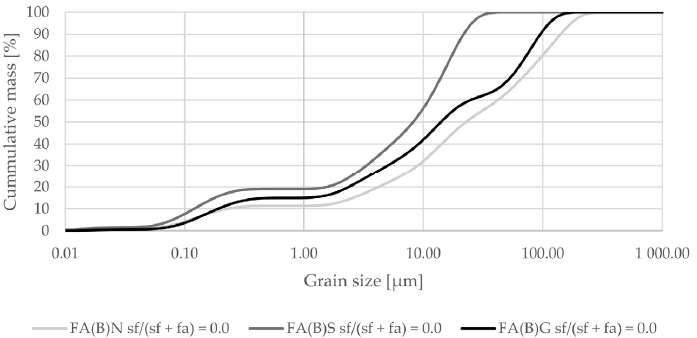
Figure 1. Grain-size distribution of fly ash activated by sieving or grinding compared to the grain-size distribution of untreated fly ash (logarithmic scale).